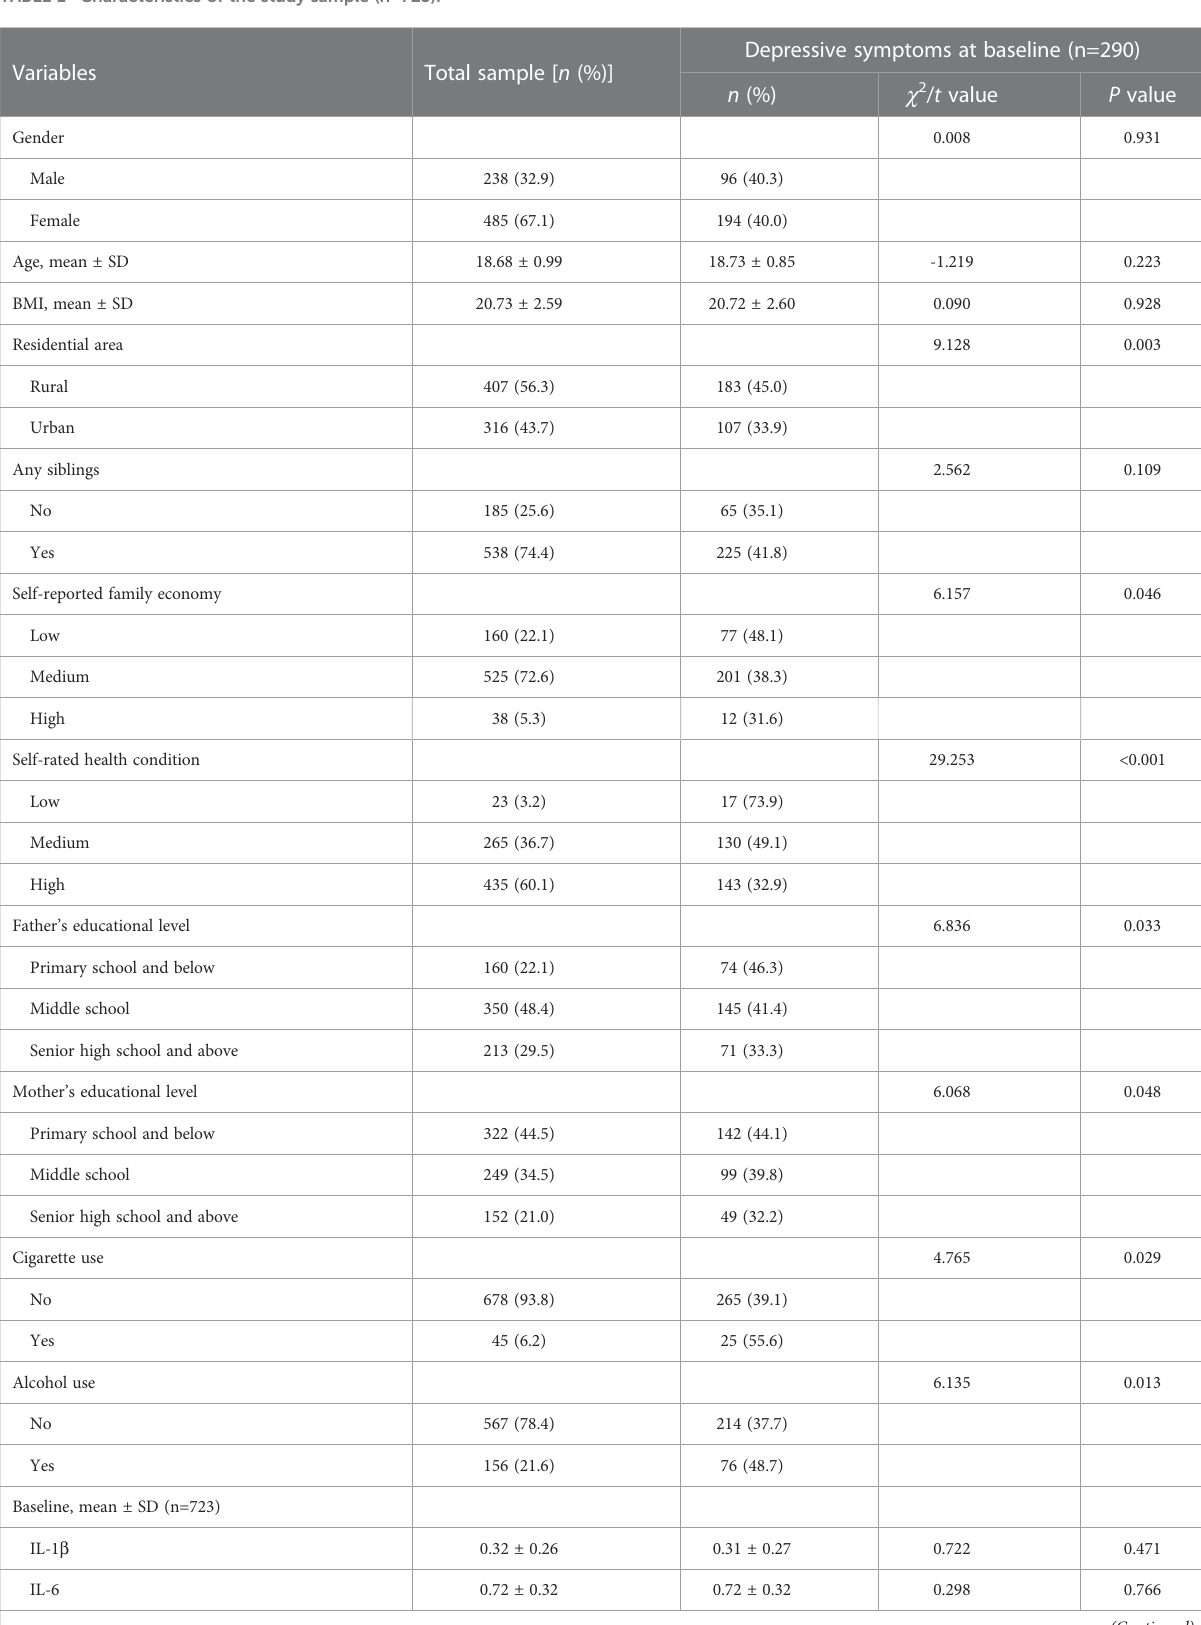
TABLE 1 Characteristics of the study sample